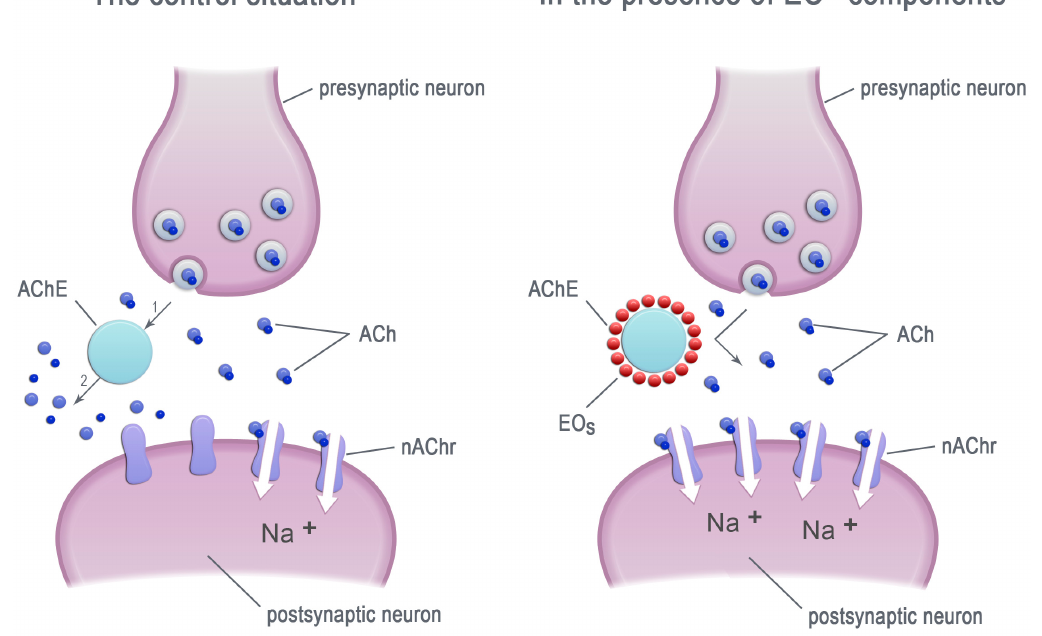
Figure 1. The EO components inhibit the acetylcholinesterase (AChE) activity. ACh—acetylcholinesterase, nAChr—nicotinic acetylcholine receptors, EOs—essential oil components.